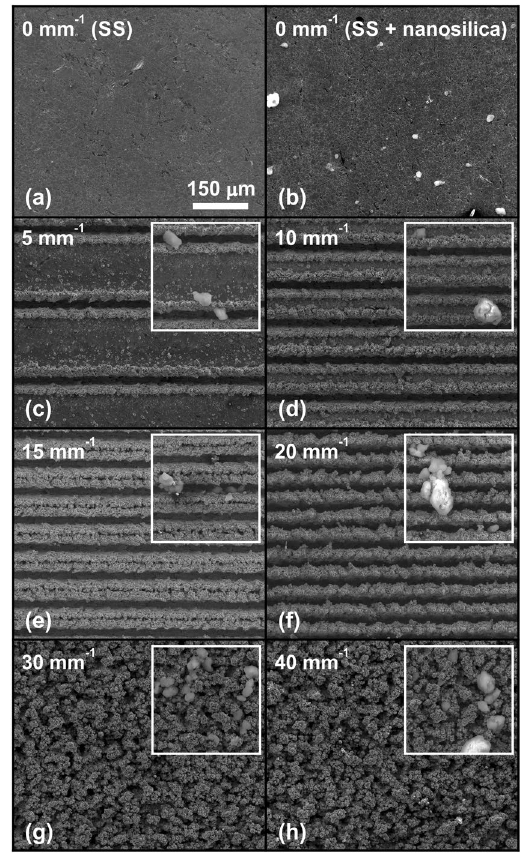
Figure 1. SEM micrographs of ( a ) an unprocessed surface (SS), ( b ) SS with 30-nm nanosilica particles and ( c – h ) laser-textured surfaces with different line densities Δ y − 1 ; the insets show the same surfaces after the adsorption of nanosilica particles. The scale is shown in ( a ) and it is the same for all the